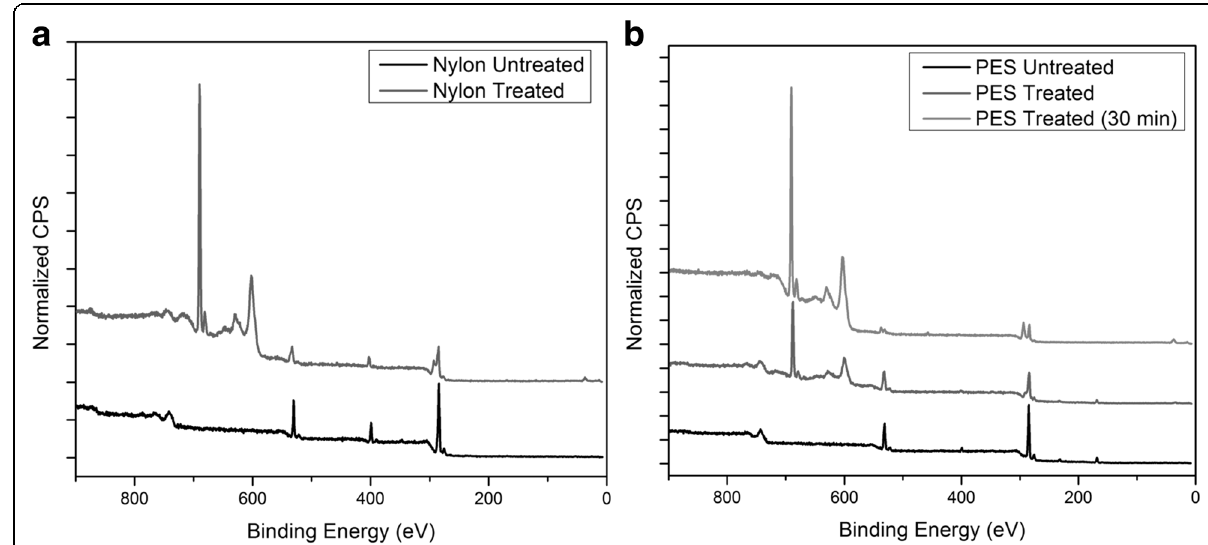
Fig. 8 XPS core level spectra for untreated and CF4 plasma treated ( a ) nylon and ( b ) PES